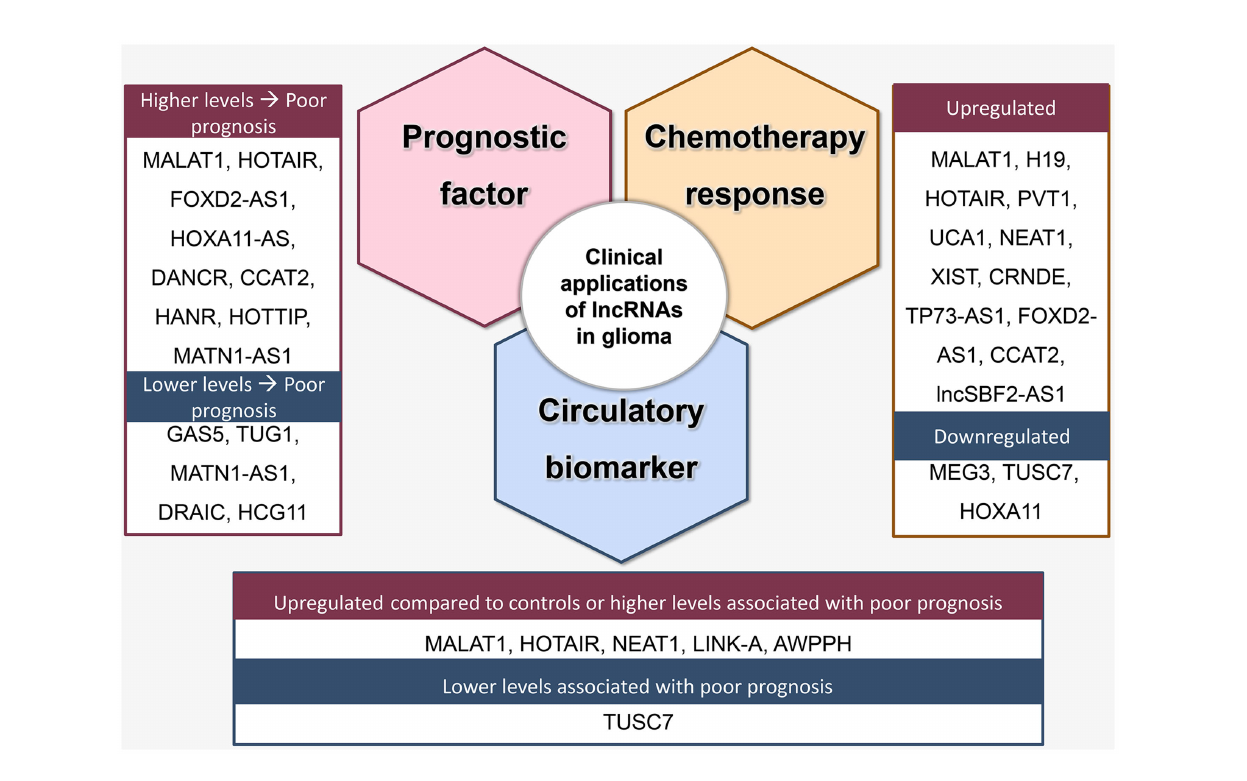
FIGURE 3 | Clinical applications of lncRNA as prognostic factors, predictors of treatment response, and circulatory